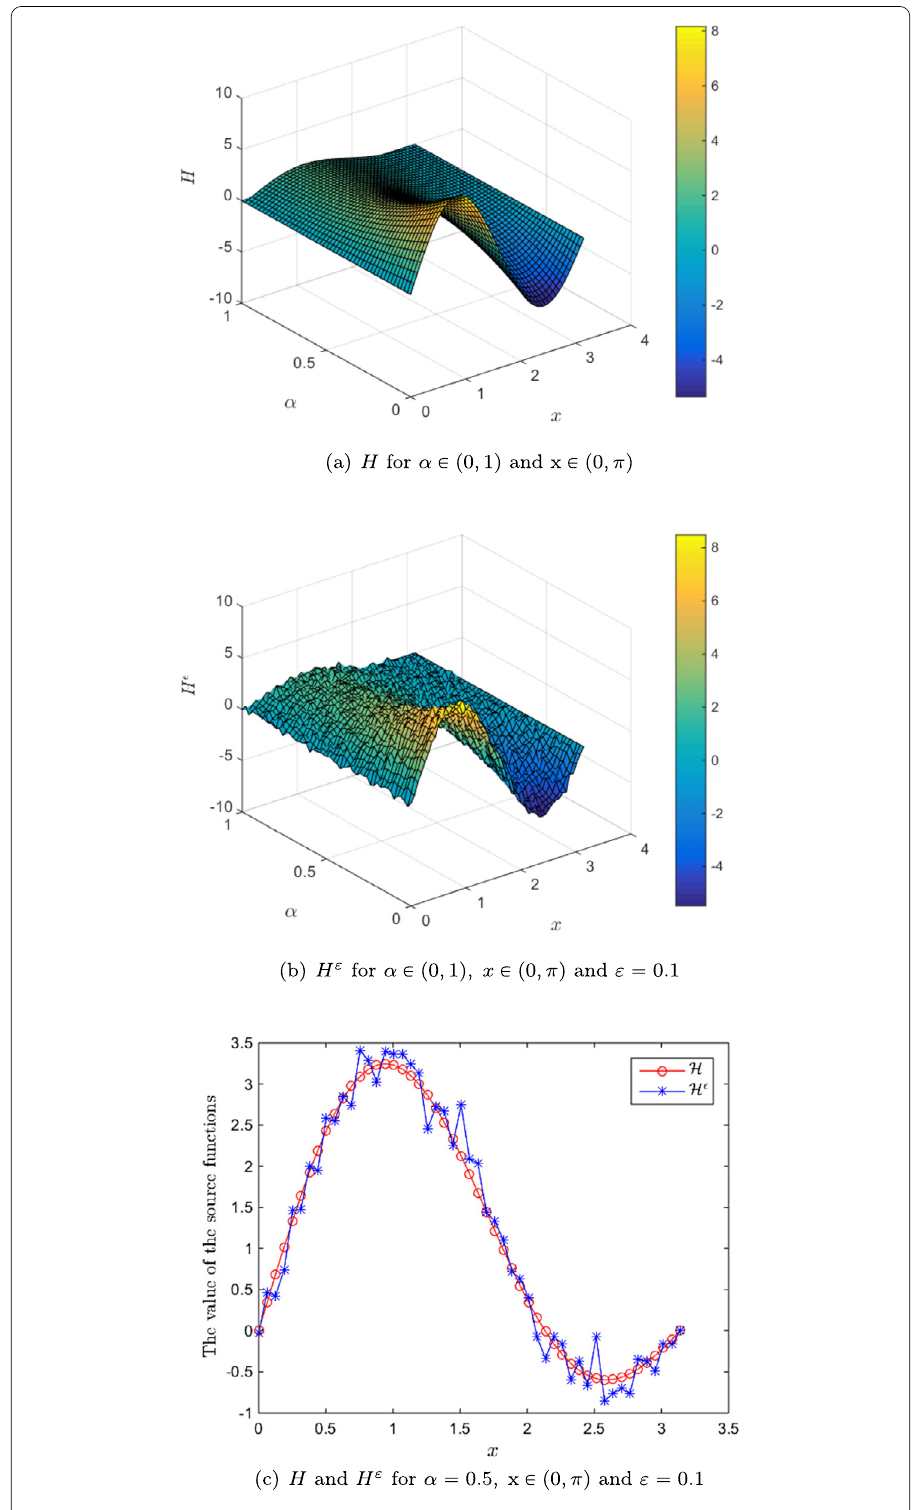
Figure 3 The graph of functions H and H